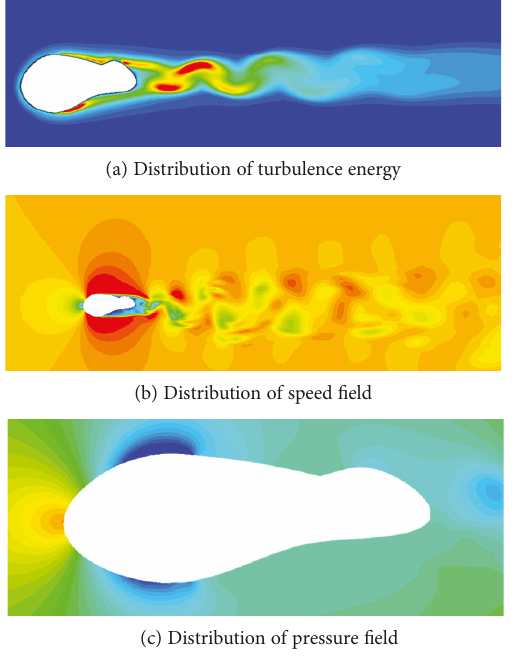
Figure 3: Flow fi eld distribution of asymmetric cross-section rod.